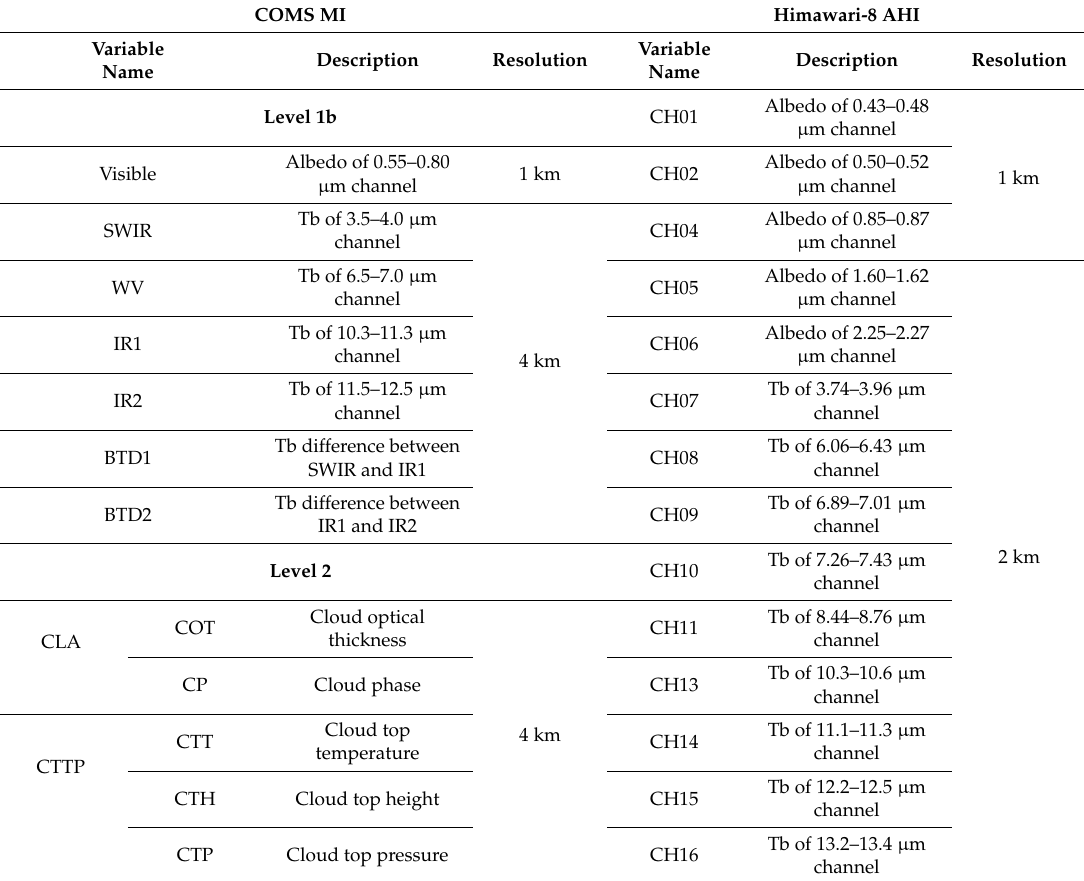
Table 1. Specification of variables of Communication, Ocean and Meteorological Satellite (COMS) Meteorological Imager (MI) and Himawari-8 Advanced Himawari Imager (AHI) used in developing icing detection models in this study (Tb = Brightness